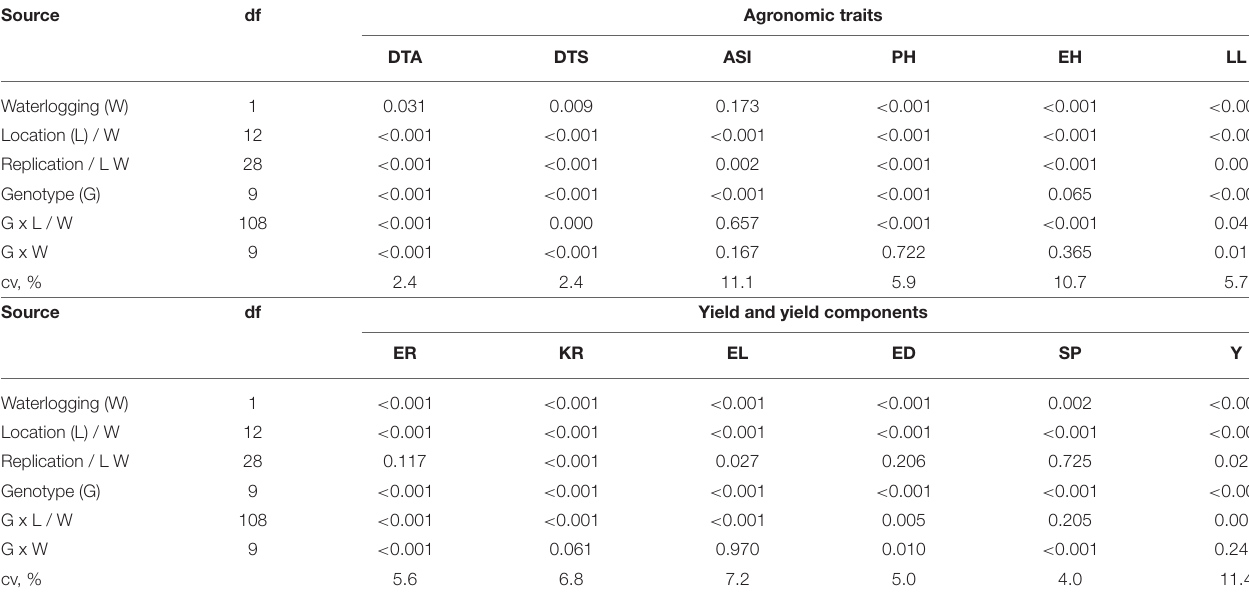
TABLE 2 | Combined analysis of variance ( p -values) across environments for agronomic and yield traits in